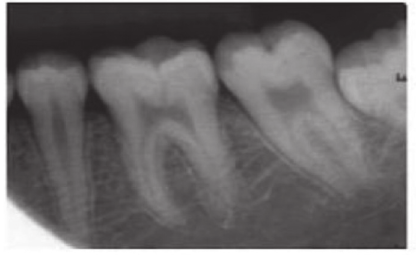
Figure 2: Periapical